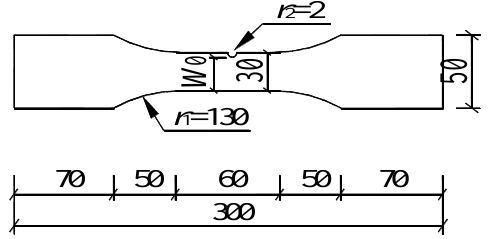
Figure 1. Geometry of the Q460C steel notched plates.